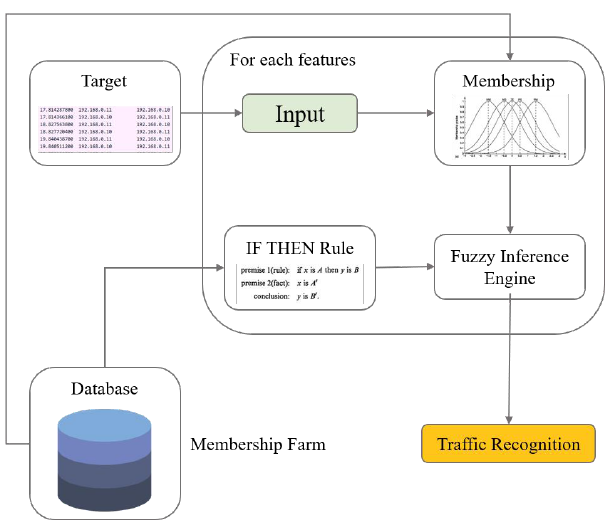
Figure 7. A structure that judges the degree of conformance to a specific traffic type of target traffic through the If–Then rule. This is a series of processes that combine several judgment rules. The rules shown above are the case of including all features.